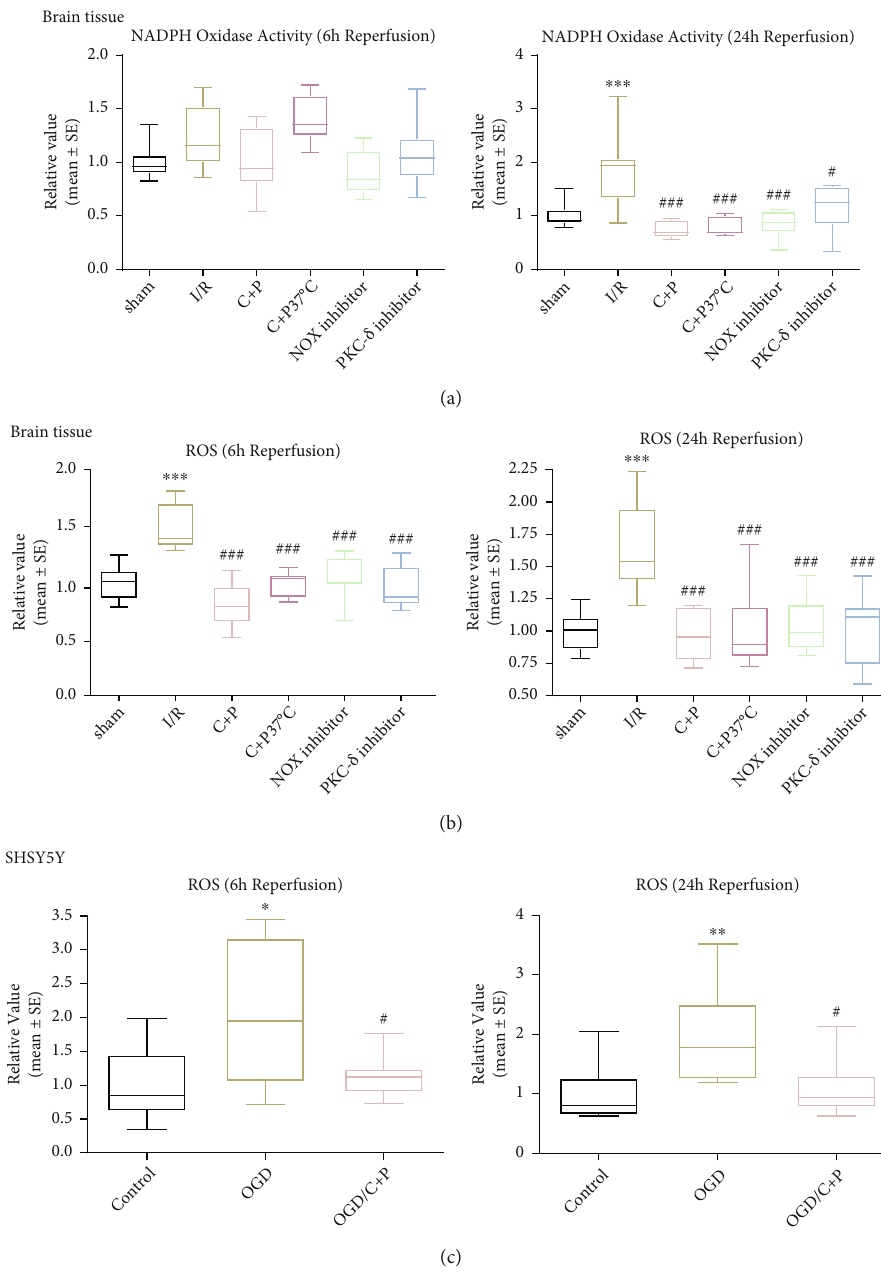
Figure 2: C+P attenuated NOX activity and ROS level postreperfusion. Quantitative analysis of (a) NOX activity and (b) ROS level as determined in ischemic brain tissue. NOX activity was higher at 24 hours of reperfusion, and ROS levels were also higher at 6 and 24 hours of reperfusion. Decreased NOX activity levels at 24 hours of reperfusion and ROS at 6 and 24 hours of reperfusion were observed in C+P groups regardless of temperature control as well as in PKC- δ or NOX inhibitor groups ( n = 7 ). ∗∗∗ p < 0 : 001 versus the sham group; # p < 0 : 05 , ### p < 0 : 001 versus the I/R group. Data is shown as the mean ± SE . Quantitative analysis of (c) ROS level in SHSY5Y cell was measured. C+P administration lowered the OGD-induced elevation of ROS at 6 and 24 hours of reoxygenation. ∗ p < 0 : 05 , ∗∗ p < 0 : 01 versus the OGD group; # p < 0 : 05 versus the OGD/C+P group. Results are shown as mean ± SE of three independent